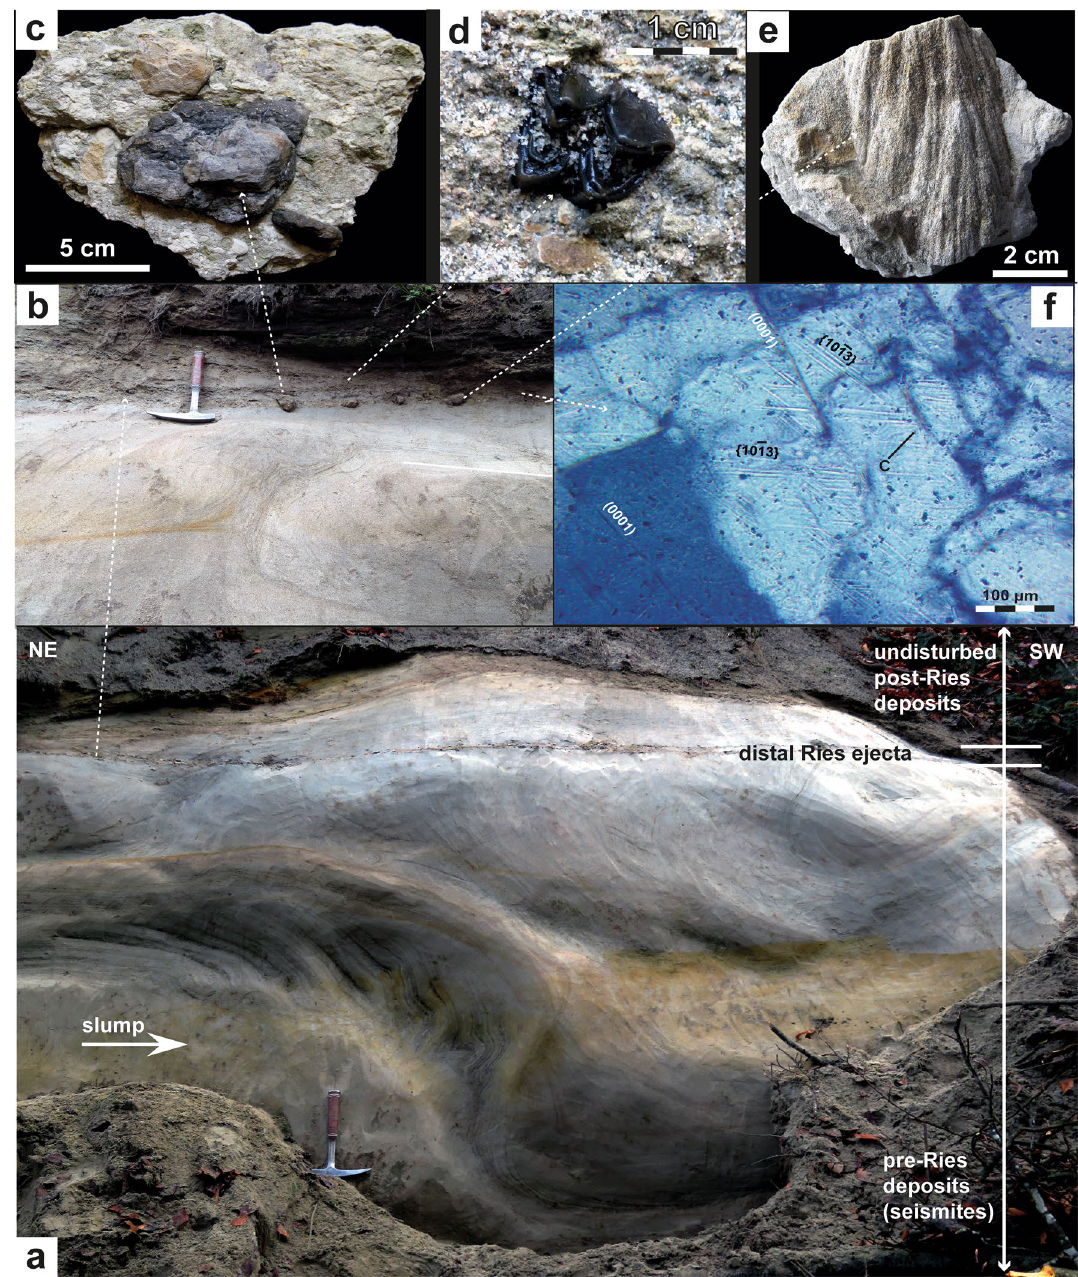
Figure 4. ( a ) Bedding conditions in the Kleintobel close to Ravensburg approxiamtely 140 km SSW of the Ries crater rim. Slumped deposits of Upper Freshwater Molasse overlain by a layer of distal Ries ejecta in situ and undisturbed deposits of post-Ries age (see hammer for scale). ( b ) Cobbles of distal Ries ejecta in situ that impacted into slumped deposits of Upper Freshwater Molasse. Note the about 5 cm deep impact depression under one of the DREL clasts (left). ( c ) Two clasts of distal Ries ejecta, one of Upper Jurassic limestone (light) and the other of Lower Jurassic claystone (dark), both connected by secondary carbonate cements. ( d ) Molar tooth of a Middle Miocene deer ( Heteroprox sp. ). ( e ) Shatter cone in an ejected cobble of Upper Jurassic limestone. ( f ) Shocked quartz grain with at least three sets of planar fractures and planar deformation features and their crystallographic orientation from the sandy portion of the Ries ejecta horizon at this locality. Photographs ( a – e ) taken by V.J.S. and (f) by